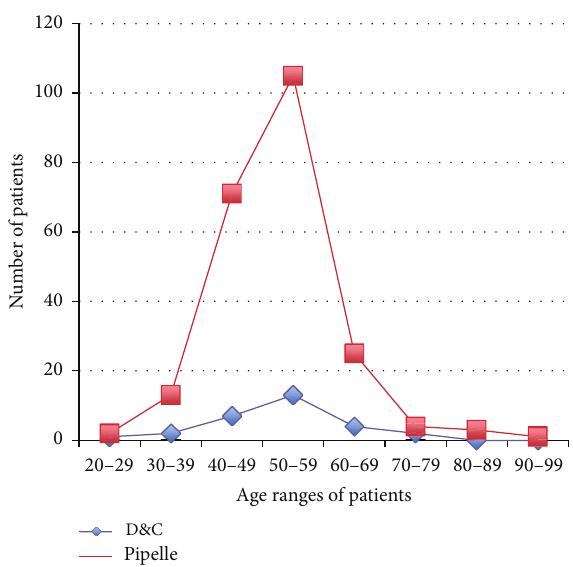
Figure 3: A diagram showing the age clustering of women with inadequate endometrial